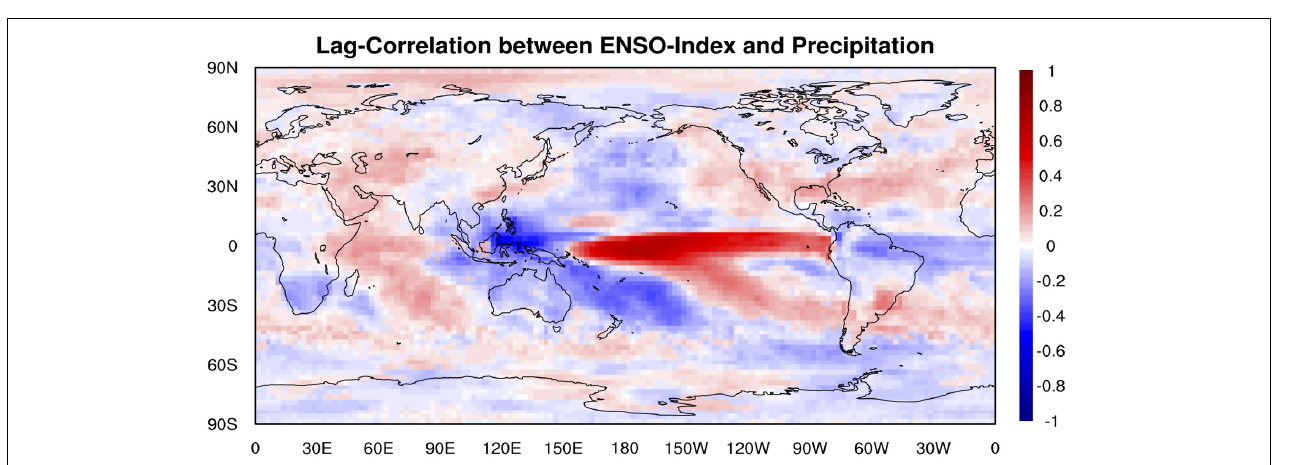
FIGURE 9 | (A) Regions where surface precipitation is granger caused by ENSO index (red shaded). (B) Regions where surface precipitation causes ENSO (red shaded).